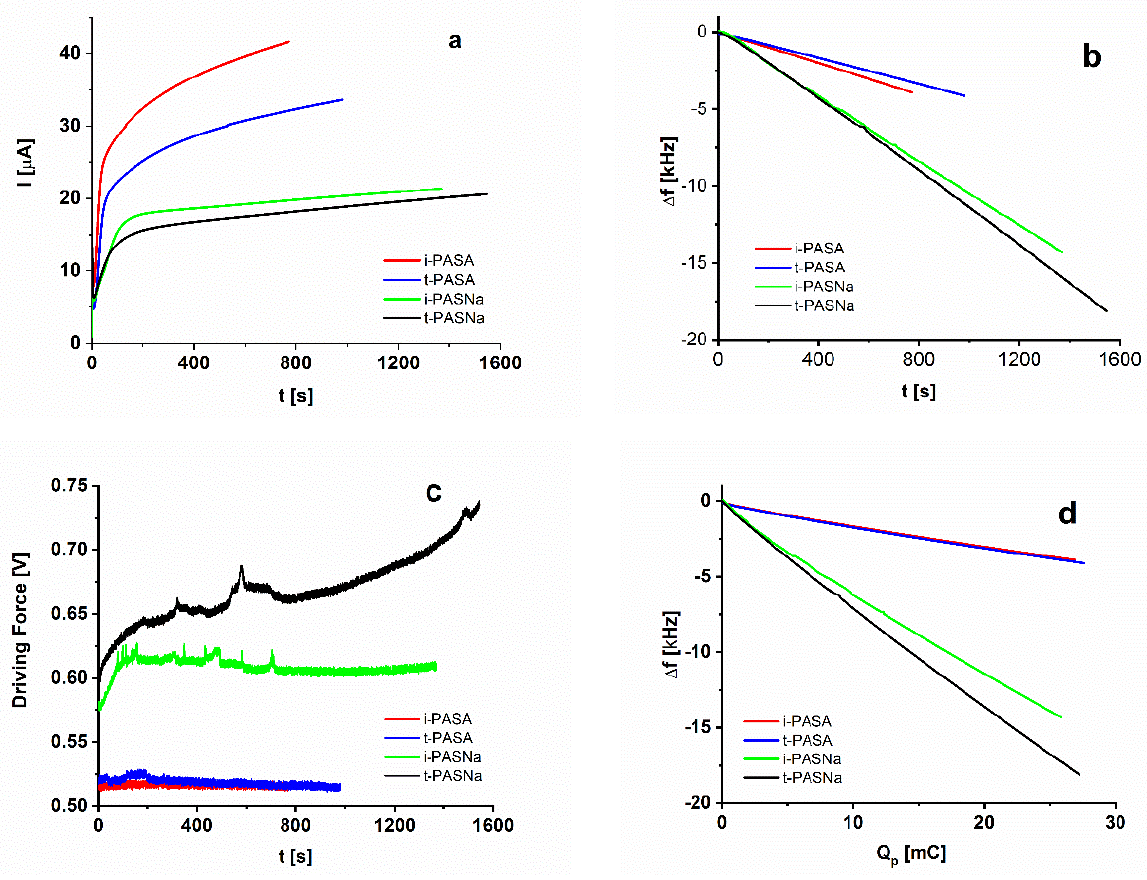
Figure 1. Current ( a ), frequency shift ( b , d ), and driving force ( c ) measurements in the course of potentiostatic polymerization in the presence of i-PASA (red) t-PASA (blue), i-PASNa (green) and t-PASNa